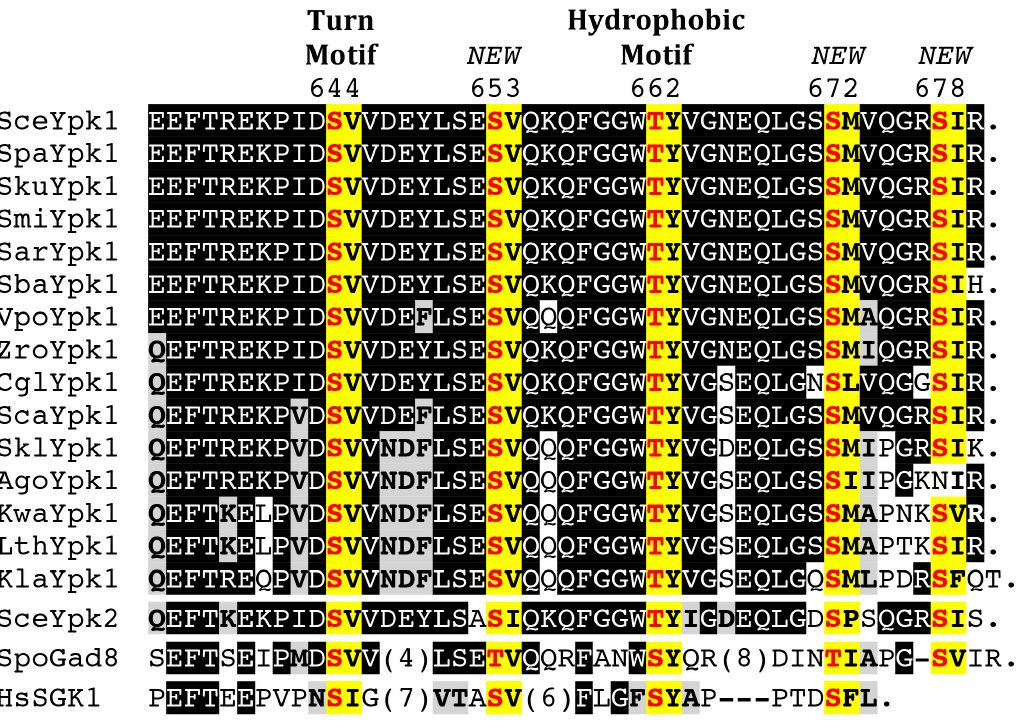
Figure 5. Conservation of sites phosphorylated by TORC2 in Ypk1. The C ‐ terminal end of Saccharomyces cerevisiae (Sce) Ypk1 (top line) was aligned with the corresponding segment of Ypk1 orthologs from sensu stricto Saccharomyces species S. paradoxus (Spa), S. kudriavzevii (Sku), S. mikatae (Smi), S. arboricola (Sar), and S. bayanus (Sba), more divergent species Vanderwaltozyma polyspora (Vpo), Zygosaccharomyces rouxii (Zro), Candida glabrata (Cgl), S. castellii (Sca), S. kluyveri (Skl), Ashbya gossypii (Ago), Kluveromyces waltii (Kwa), Lachancea thermotolerans (Lth), and Kluveromyces lactis (Kla), SceYpk2, Schizosaccharomyces pombe (Spo), and Homo sapiens (Hs) SGK1 (bottom line). Identities (white letters on black boxe s ) and standard conservative substitutions (bold letters on grey boxes) shared between SceYpk1 and another ortholog are indicated. One ‐ residue gaps (hyphens) and insertions of the indicated length (parentheses) were introduced to maximize alignment of the most distant orthologs. Period (.) indicates the end of the open ‐ reading ‐ frame. The proximal seven ‐ residue insert in HsSGK1 contains two additional potential mTORC2 sites (K SP D SV L). Sequence sources can be found in [39].